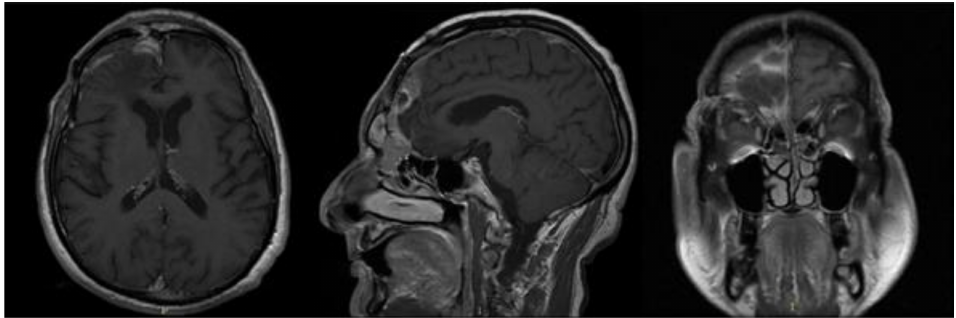
Figure 3. First recurrence of the lesion involving the cribriform plate (T1-weighted with